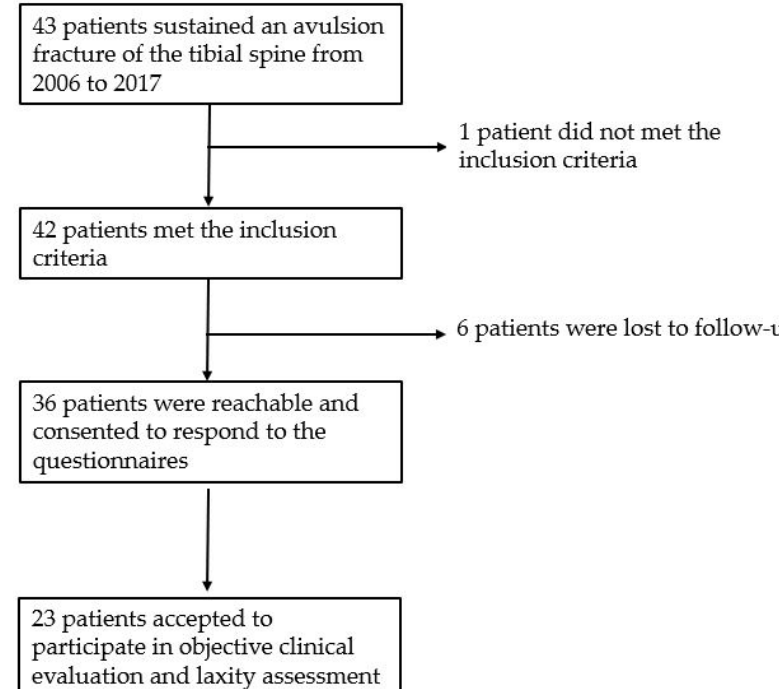
Figure 1. Flow-chart of patients who were lost to follow-up. Figure 1. Flow ‐ chart of patients who were lost to follow ‐ up.